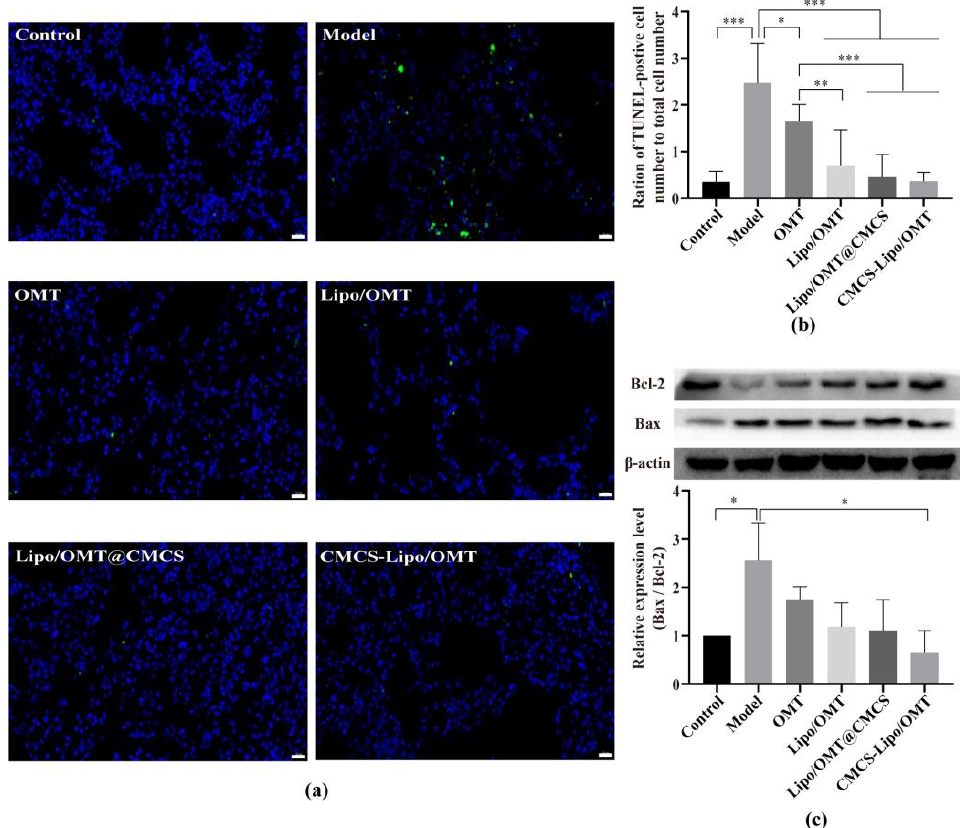
Figure 4. Regulation of OMT and its liposomal preparations on PPE-activated alveolar cell death in emphysema mice lungs. ( a ) Representative lung section images of each group, analyzed by TUNEL assay (scale bar = 20 μ m), in which the apoptotic alveolar cell apoptosis (green) and nuclei (blue) were labeled. ( b ) Changes in the ratio of TUNEL-positive cell number to total cell number in the lung sections of each group of mice. ( c ) Western blotting analysis and quantitative analysis of the relative expression of Bax/Bcl-2 in lung tissues. All data are expressed as mean ± SD ( n = 3). * p < 0.05, ** p < 0.01, *** p < 0.001.